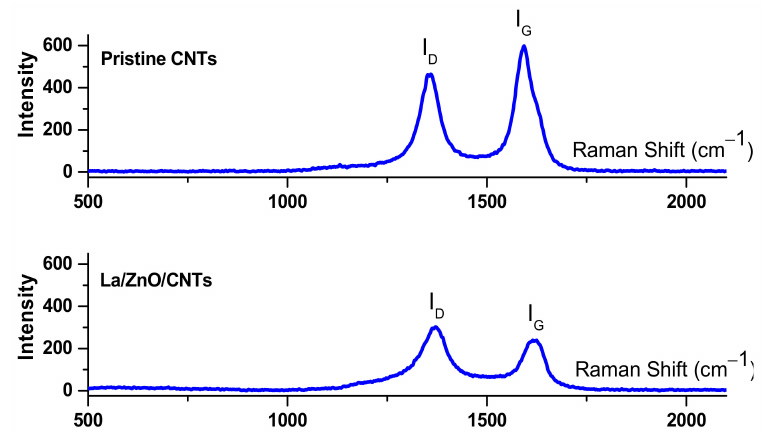
Figure 5. Raman spectra of pristine CNTs and La/ZnO/CNTs composite photocatalyst.